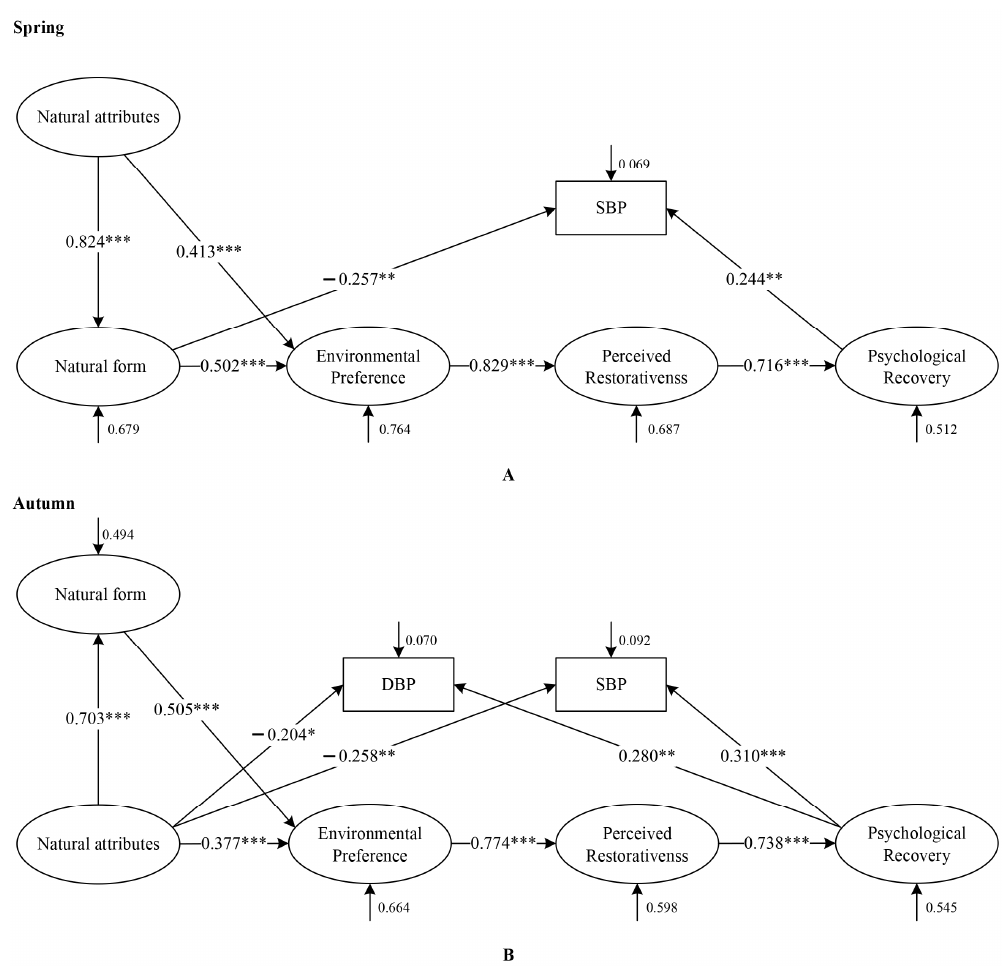
Figure 7. Differences in the relationship between landscape perception and physical and mental recovery across seasons. ( A ): Spring. ( B ): Autumn. Spring fitting indexes: Chi-square/df = 1.14, GFI = 0.94, AGFI = 0.93, RMSEA = 0.02, IFI = 0.99, NFI = 0.94, CFI = 0.99, TLI = 0.99, RFI = 0.94. Autumn fitting indexes: Chi-square/df = 1.18, GFI = 0.94, AGFI = 0.92, RMSEA = 0.03, IFI = 0.99, NFI = 0.94, CFI = 0.99, TLI = 0.99, RFI = 0.93. The two models fit well. * p < 0.05; ** p < 0.01; *** p < 0.001. SBP: systolic blood pressure; DBP: diastolic blood pressure. This figure was created by Rui Chen.